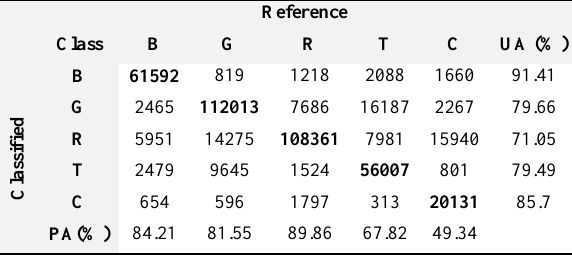
Table 2. Confusion Matrix of the SVM classifier. B=Buildings; G = Grasses; R = Roads; T = Trees C = Cars; UA = User Accuracy; PA = Producer Accuracy.